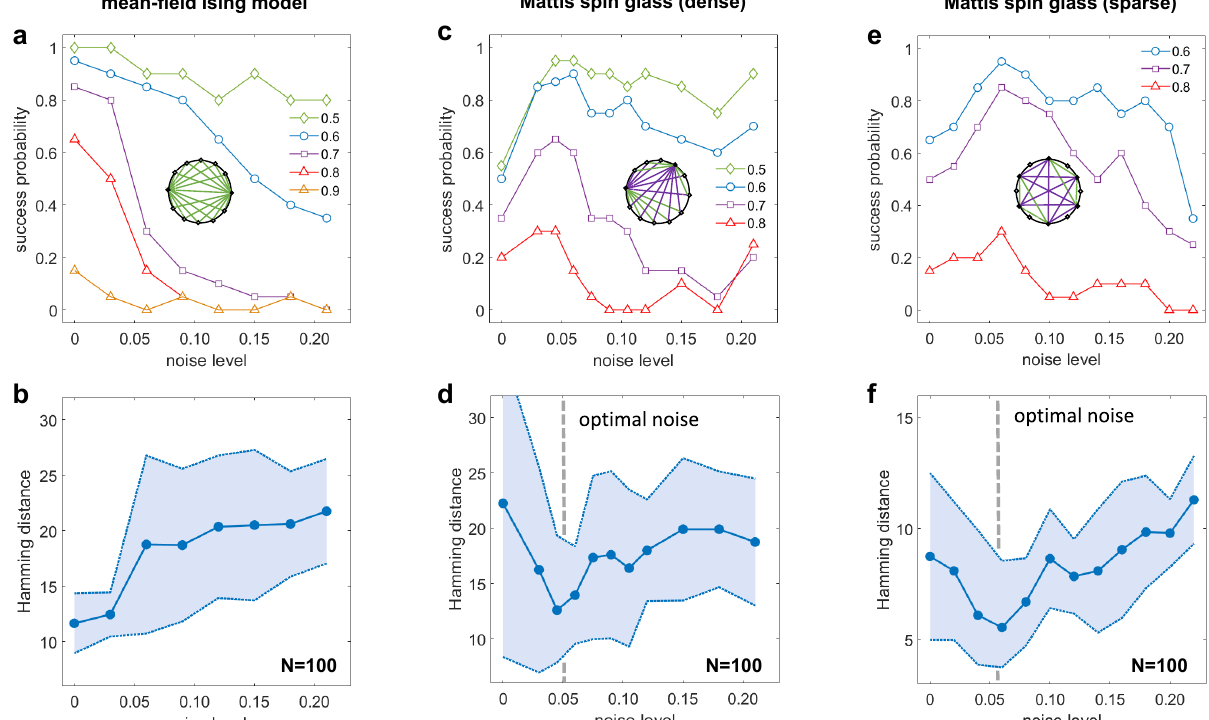
Figure3: Optimalnoiselevelinspatial-photonicIsingmachines.(a,c,e)Successprobabilityand(b,d,f)meanHammingdistancevaryingthe noise level for various N = 100 Ising models: (a – b) mean- fi eld Ising model, (c – d) dense and (e – f) sparse Mattis spin glasses. The problem graphs are inset. Different colors in (a, c, e) indicate data obtained at the speci fi ed accuracy level. Shaded regions indicate statistical error intervals.TheexistenceofanoptimalnoiselevelforfrustratedmodelsissignaledbyaminimumintheHammingdistanceandacorresponding maximum in the success probability [dotted line in (d) and